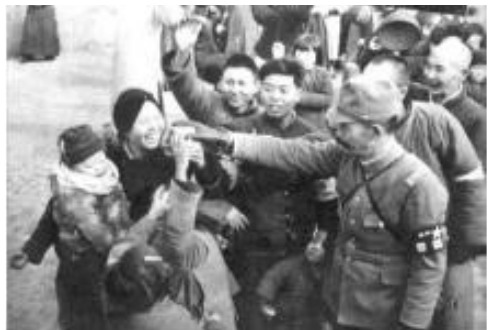
Figure 13. Japanese soldiers handing out sweets to Chinese children. Source: The Japan Advertiser.